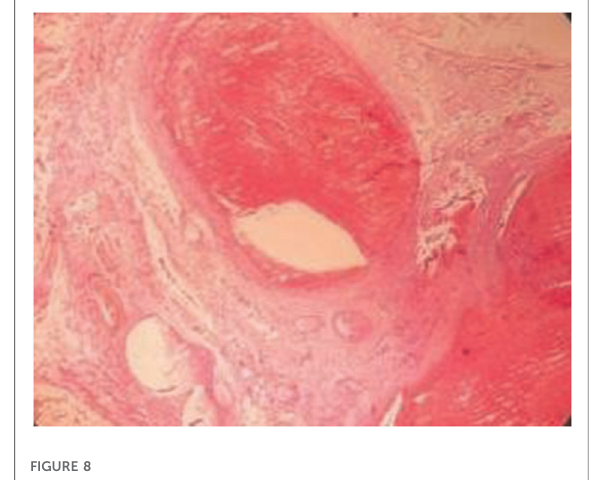
FIGURE 8 The appendix pathology (magni fi cation×100).